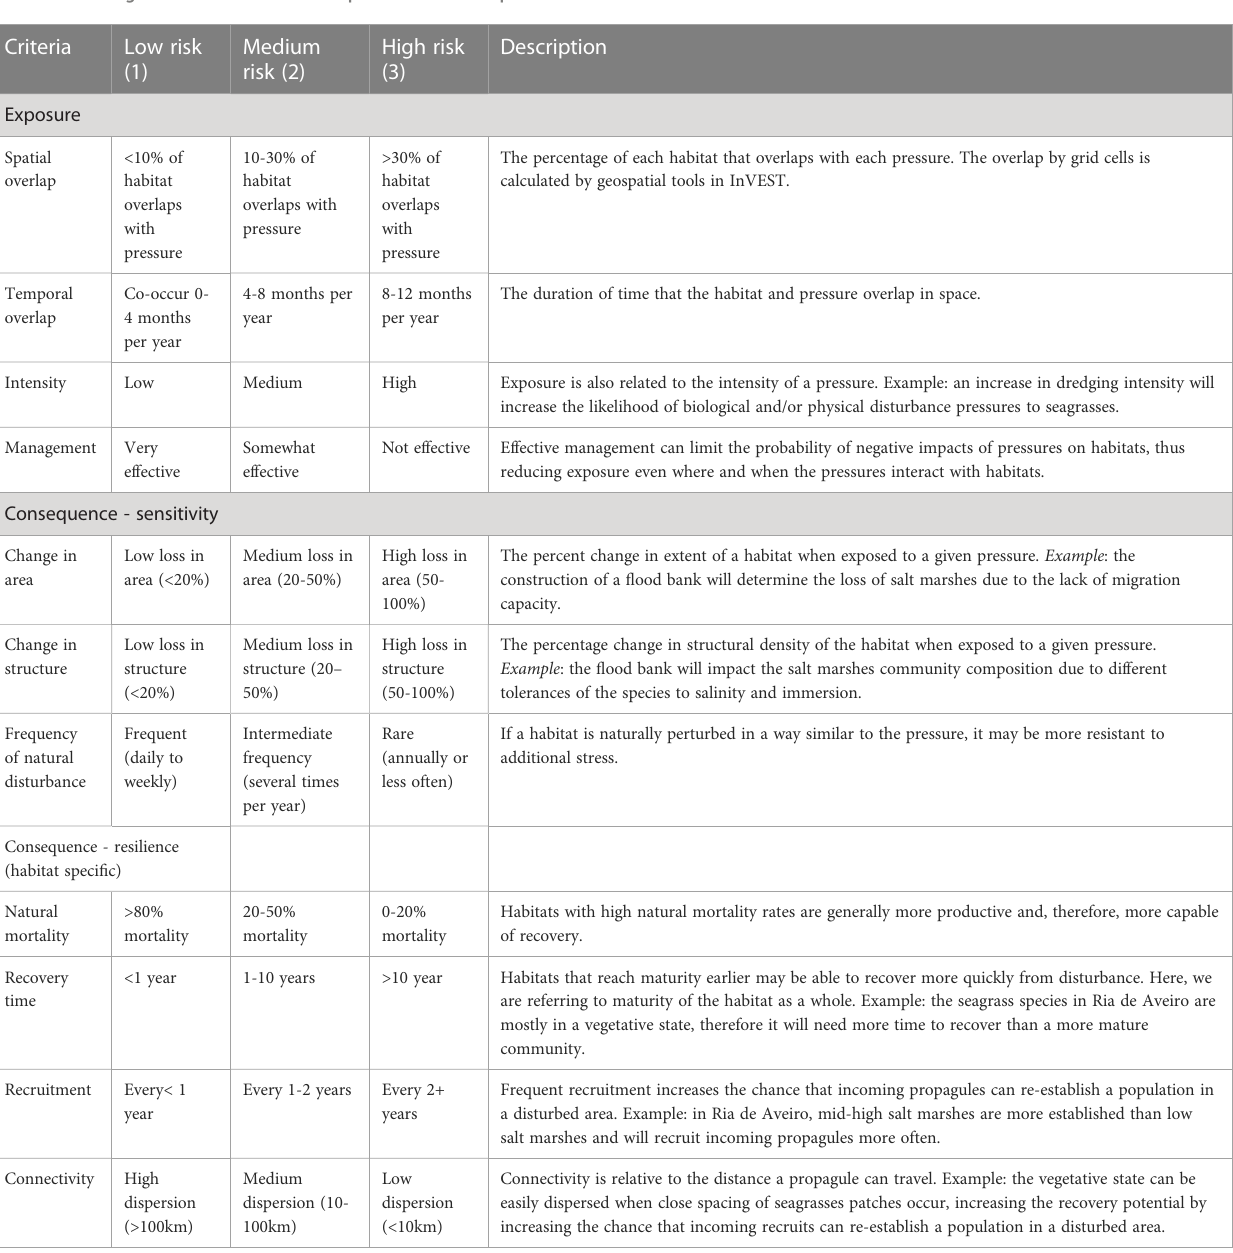
TABLE 2 Scoring and de fi nitions for the exposure and consequence criteria.